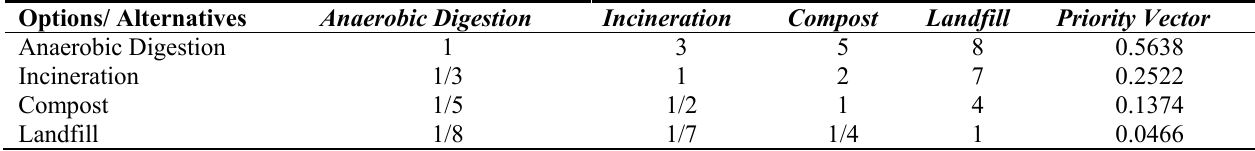
Table 4. Pairwise comparison matrix for the options with regards to environmental criteria. Options/